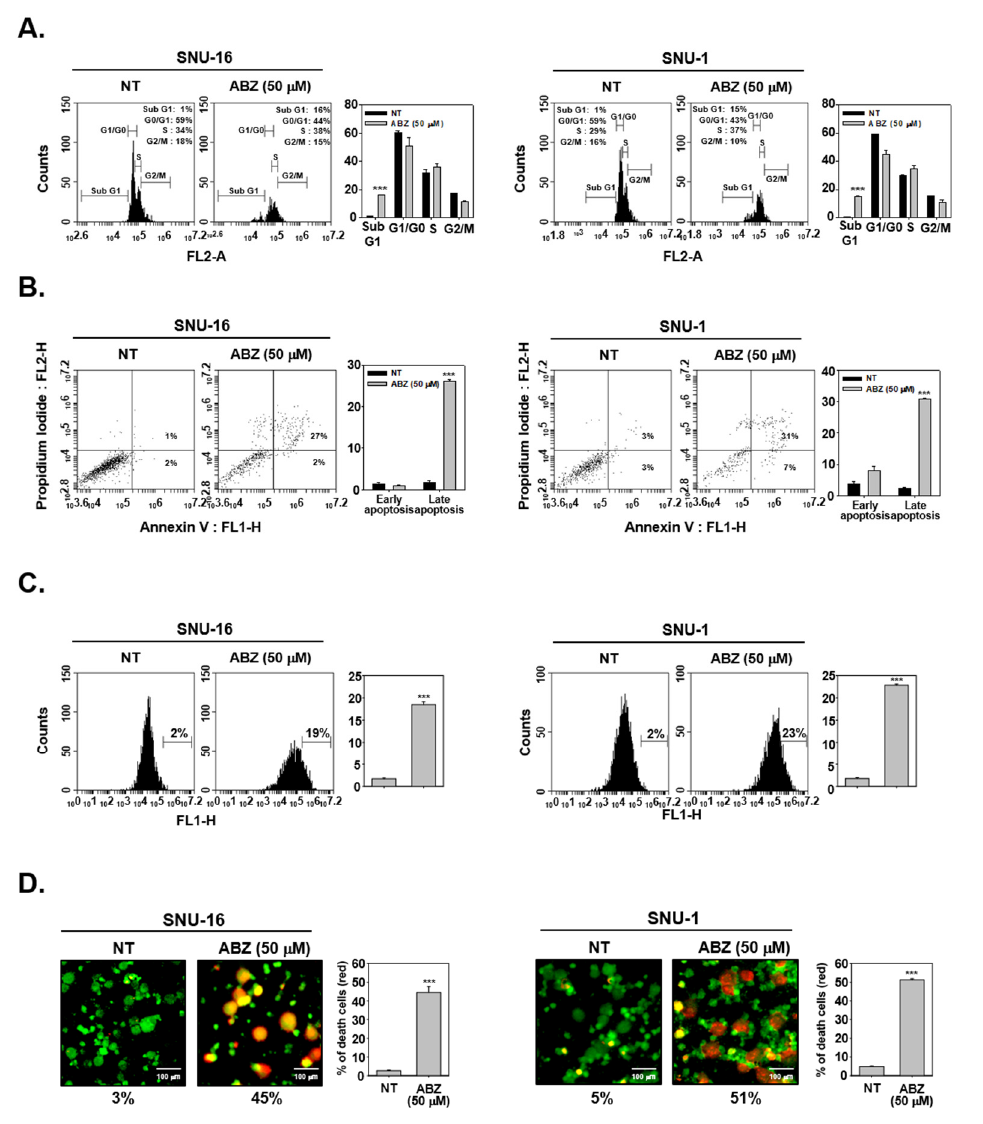
Figure 5. ABZ induces potential apoptosis . ( A – C ) SNU-16 and SNU-1 cells were treated with ABZ 50 µM for 24 h and apoptotic cells were analyzed through cell cycle analysis, Annexin V and TUNEL assays. ( D ) Cells were treated as described above in panel ( A – C ), Live and dead assay was done. Live cells were stained in green and dead cells were stained in red. The graph shows quantification of the population of dead cells. Data represent means ± SD. *** p < 0.001 vs. non-treated (NT)